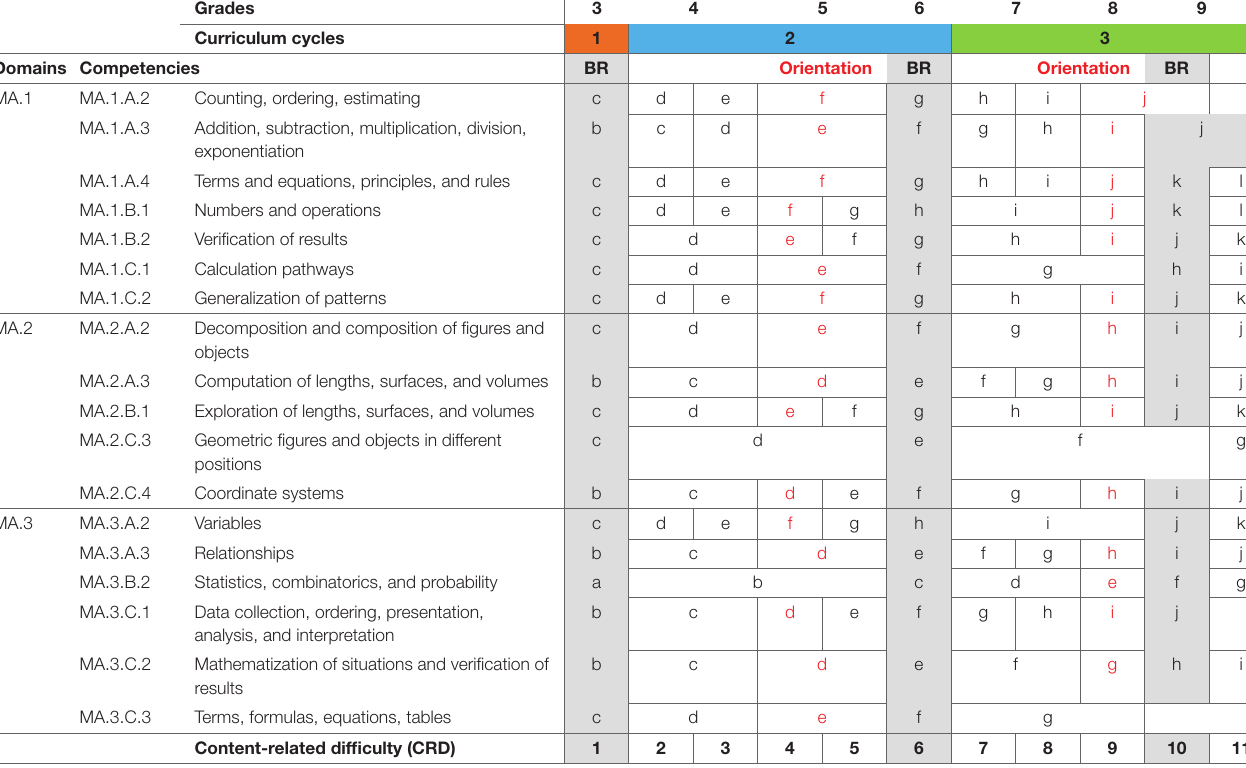
TABLE 1 | Overview of 18 mathematics competencies from curriculum Lehrplan 21 and the alignment of their competence levels with the scale for CRD. Grades Domains Competencies